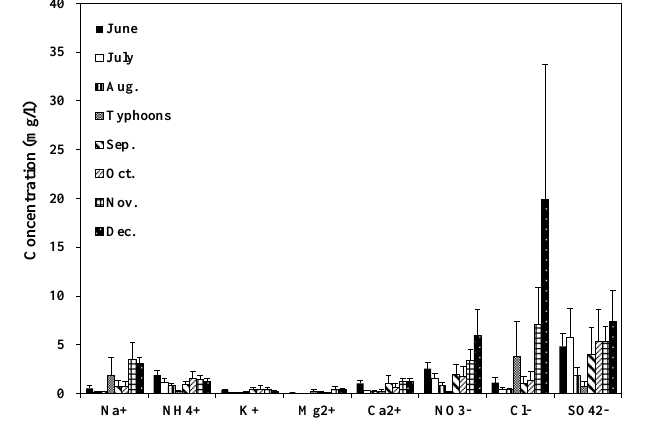
Table 4. Concentrations of trace metals in rainwater samples